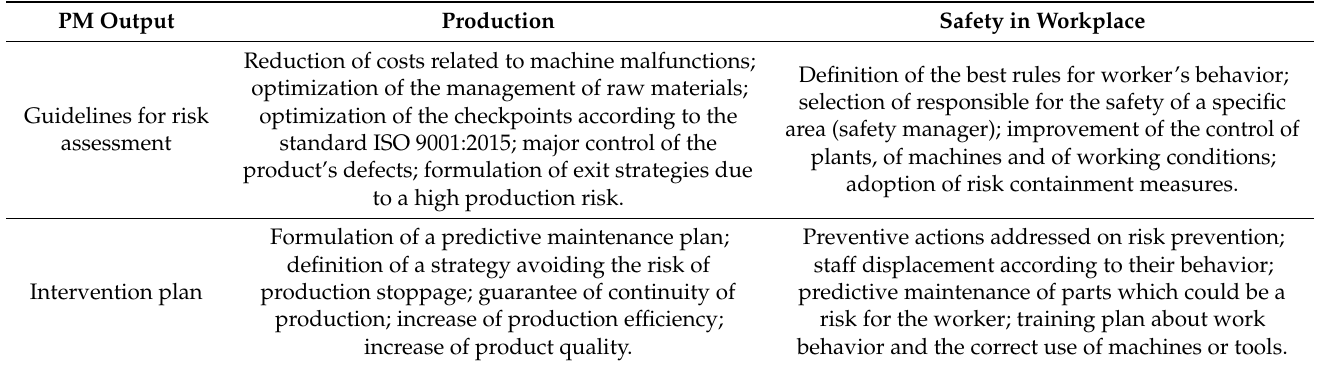
Figure 9. Flowchart representing the PM phases and the related outputs. In Table 5, the main advantages of the PM outputs are listed. Table 5. Main advantages of the PM outputs.